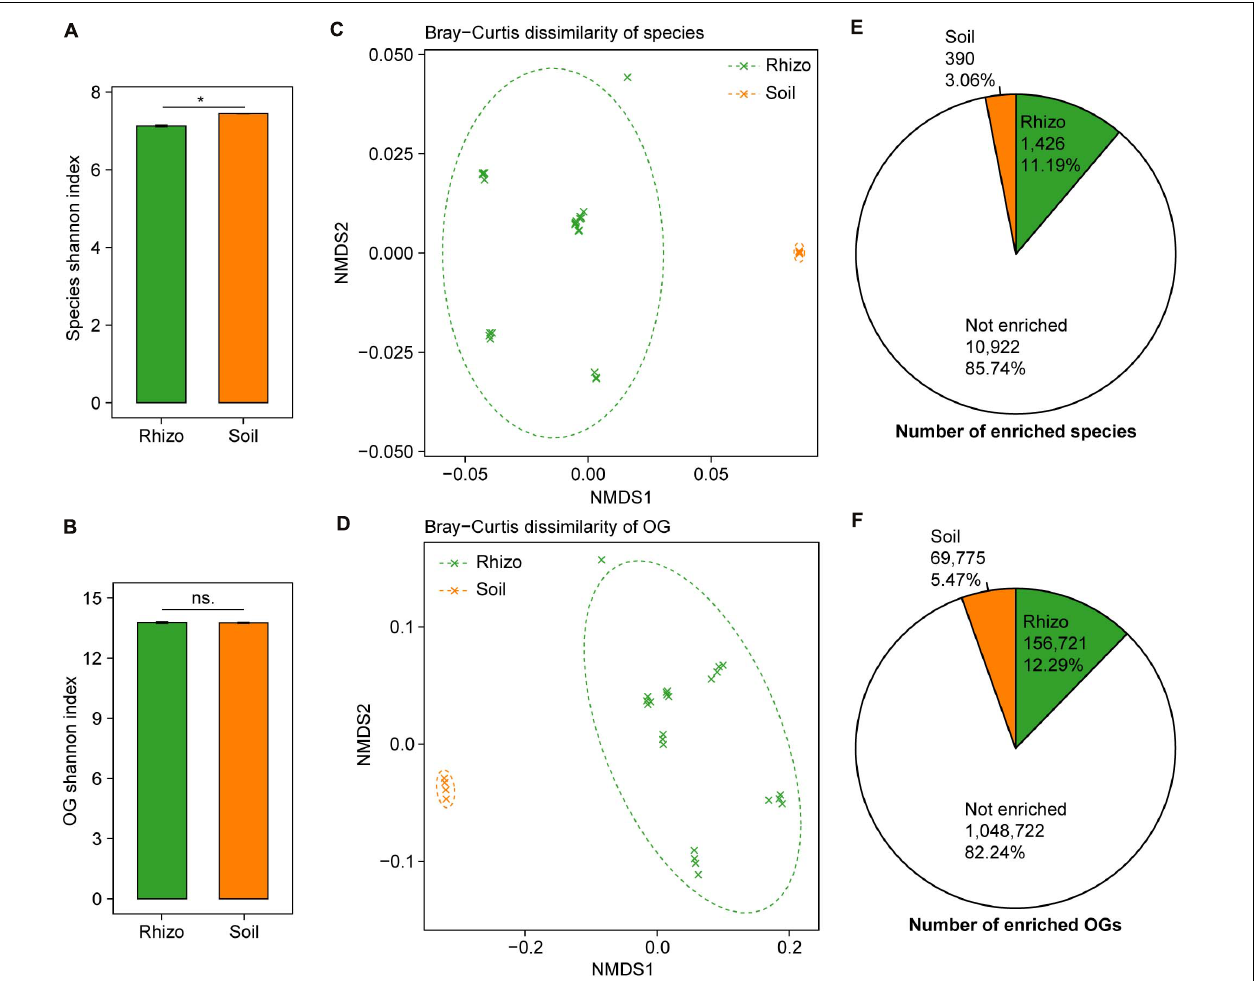
FIGURE 2 | Comparisons of microbial taxonomic and functional diversity between wheat rhizosphere (Rhizo) and bulk soil (Soil). Within-sample alpha diversity (the Shannon–Wiener index) of microbial species (A) and eggNOG Orthologous Groups (OGs) (B) between Rhizo and Soil. The error bars stand for mean ± standard error (Rhizo, n = 24; Soil, n = 4), and asterisks indicate significant differences between Rhizo and Soil ( t -test, * P < 0.05; ns, not significant). Between-sample beta diversity of species (C) and OGs (D) among Rhizo and Soil samples are analyzed by non-metric multidimensional scaling (NMDS) of the Bray–Curtis dissimilarity. Green and orange crosses refer to Rhizo and Soil samples, respectively; and the corresponding ellipses cover 90% of the data range. The number of species (E) and OGs (F) enriched in Rhizo (green pie, relative abundance ratio of Rhizo/Soil > 1.5), Soil (orange pie, Rhizo/Soil < 0.5) [Wilcoxon rank sum test,